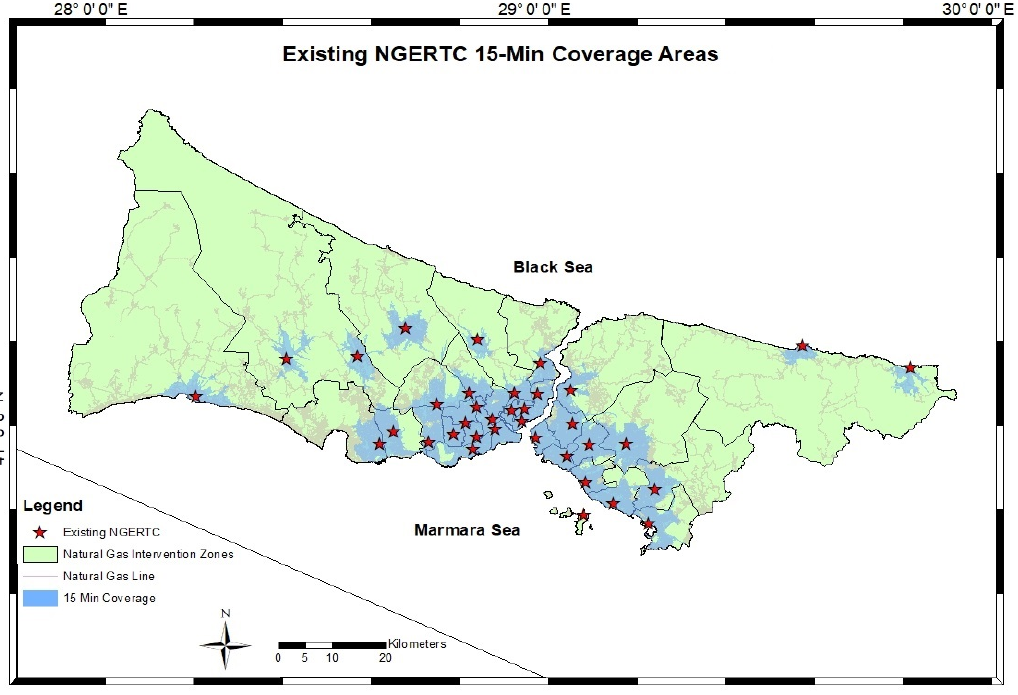
Figure 6. Natural gas emergency response team center 15 min coverage areas and natural gas intervention zones.